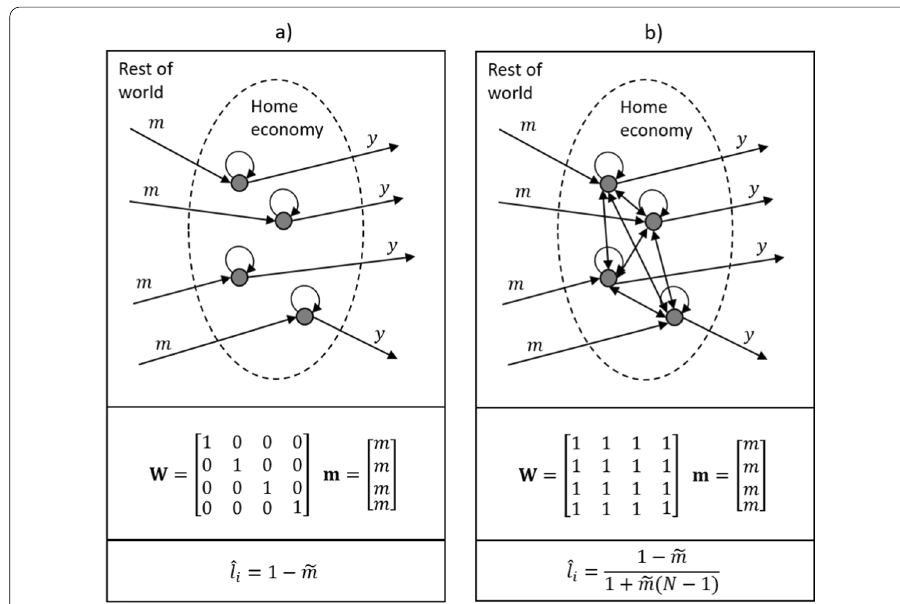
Fig. 1 The schematic framework for a domestic production network, with two extreme cases. a is an economy with isolated activities but foreign exposure, b is a balanced economy with identical internal transaction volumes